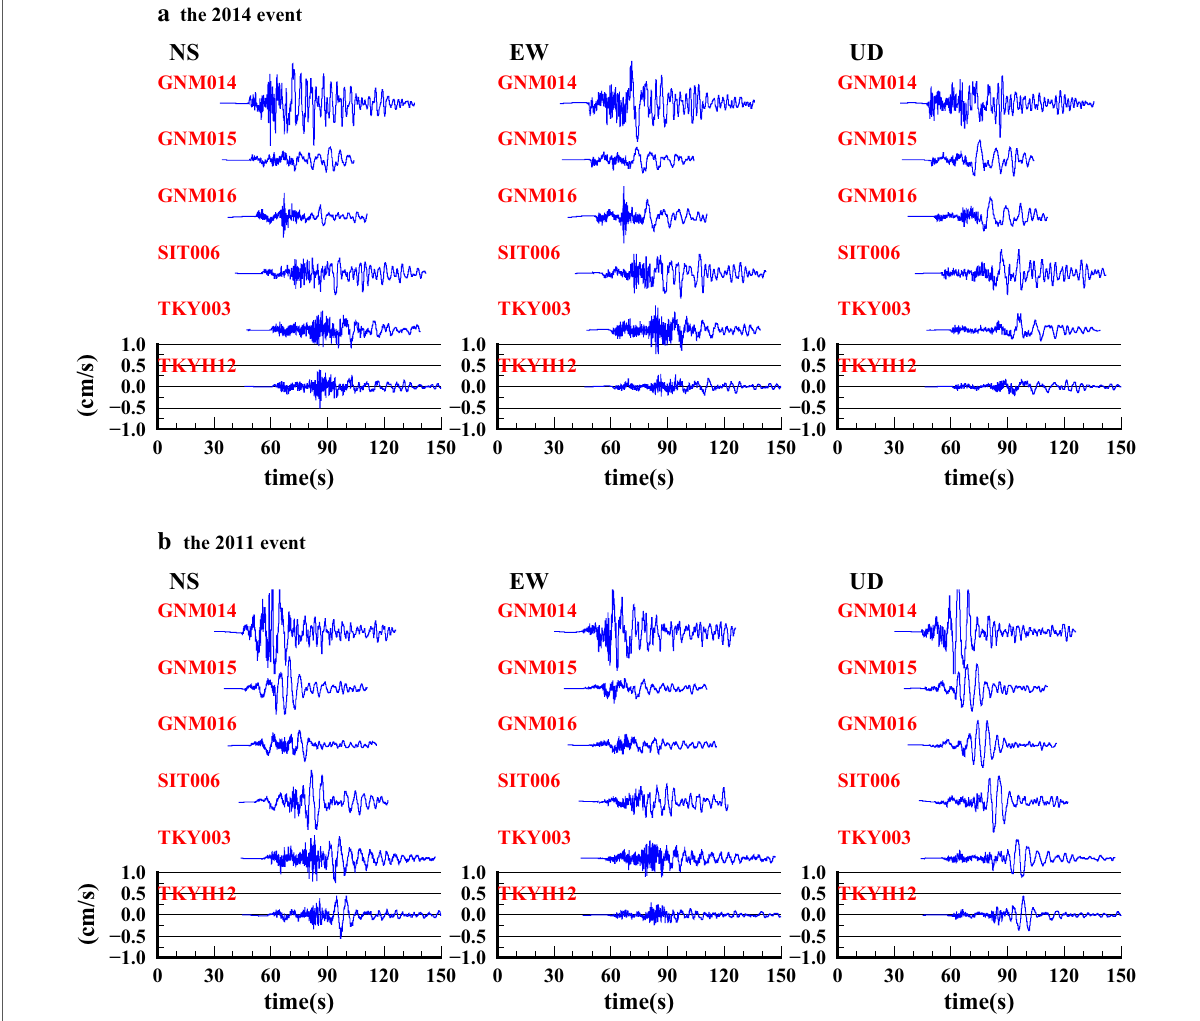
Fig. 6 Velocity waveforms at the stations located in the outside the basin area. b Show the 2011 event waveforms; a show those of the 2014 event. Columns from left to right show the NS, EW, and UD components, respectively. Characters associated with each trace indicate the station code. The location of each station is shown in Fig.